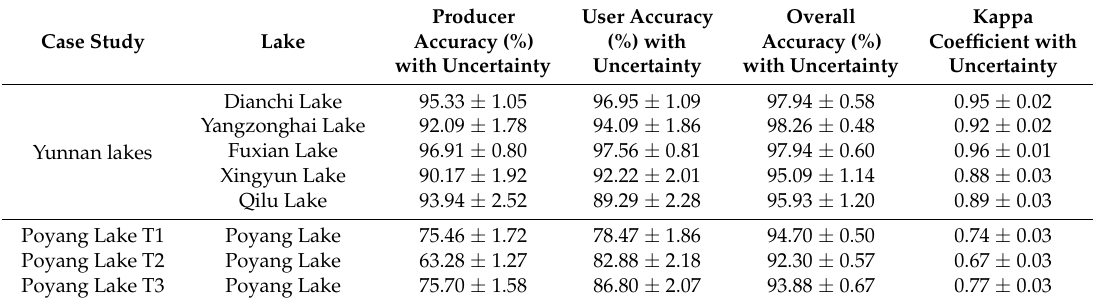
Table 4. Accuracy assessment of lake-water fraction estimation based on the subpixel confusion–uncertainty matrix